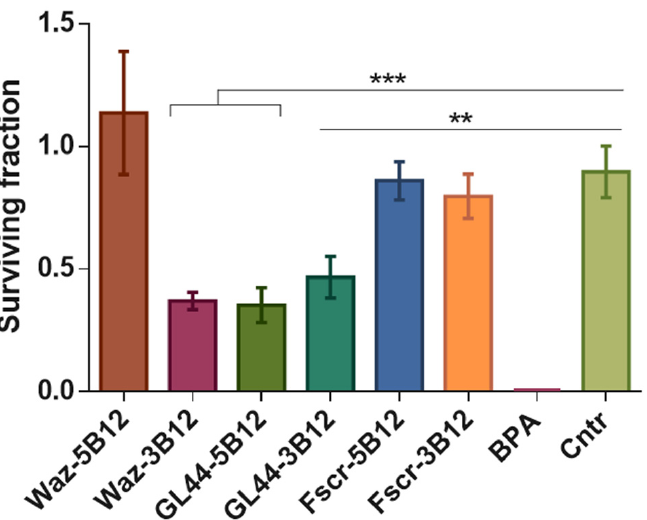
Figure 4. Surviving fractions of neutron-irradiated U-87 MG human glioblastoma cells depending on the incubation with the boron-containing 2 (cid:48) -F-RNA aptamer conjugates Waz-5B12, Waz-3B12, GL44- 5B12 or GL44-3B12 and the scrambled 2 (cid:48) -F-RNA conjugates Fscr-5B12, Fscr-3B12 or BPA. Control cells (Cntr) were irradiated without pre-treatment with any boron compounds. ** p ≤ 0.01; *** p ≤ 0.001. Three replicates were carried out in each case.